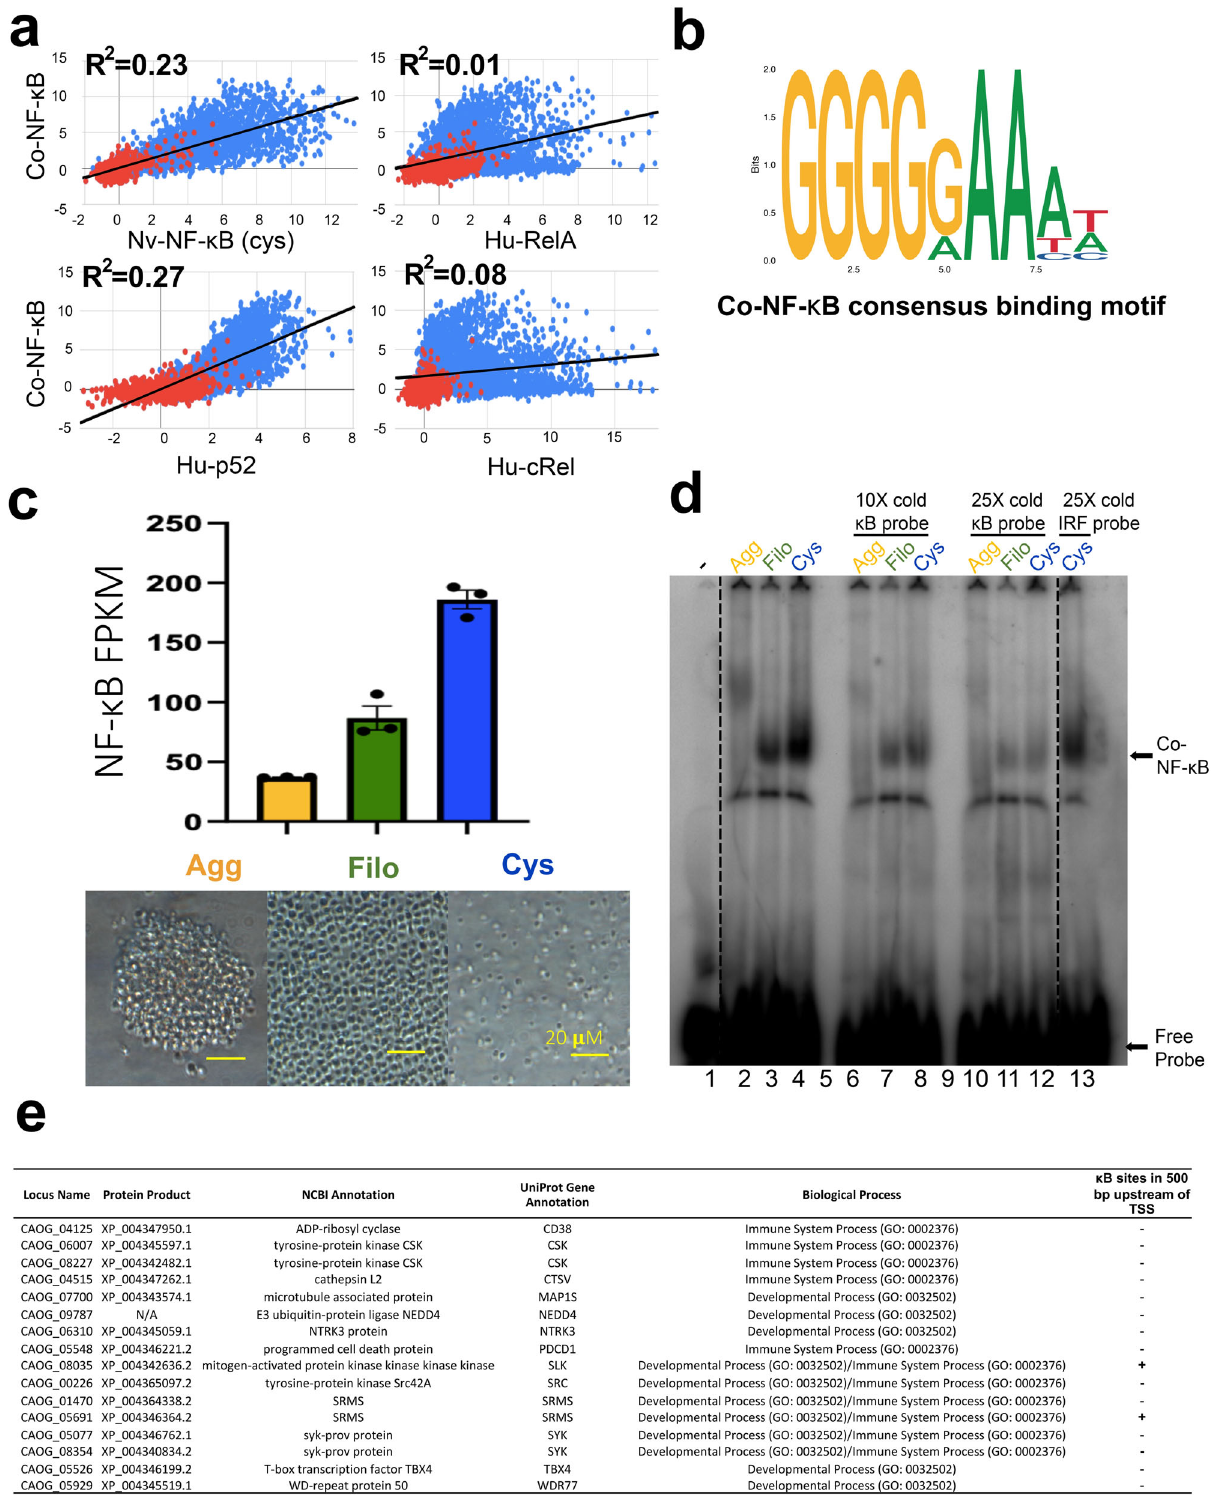
κ Bs from the sea anemone N. vectensis and human p52, and it is distinct from human cRel and RelA (Fig. 5a; (Co-NF- κ B vs.: Nv- cRel, R 2 = 0.08), which is consistent with the sequence and structural data indicating that Co -NF- κ B is more like NF- κ B proteins than Rel proteins. Based on these PBM data,